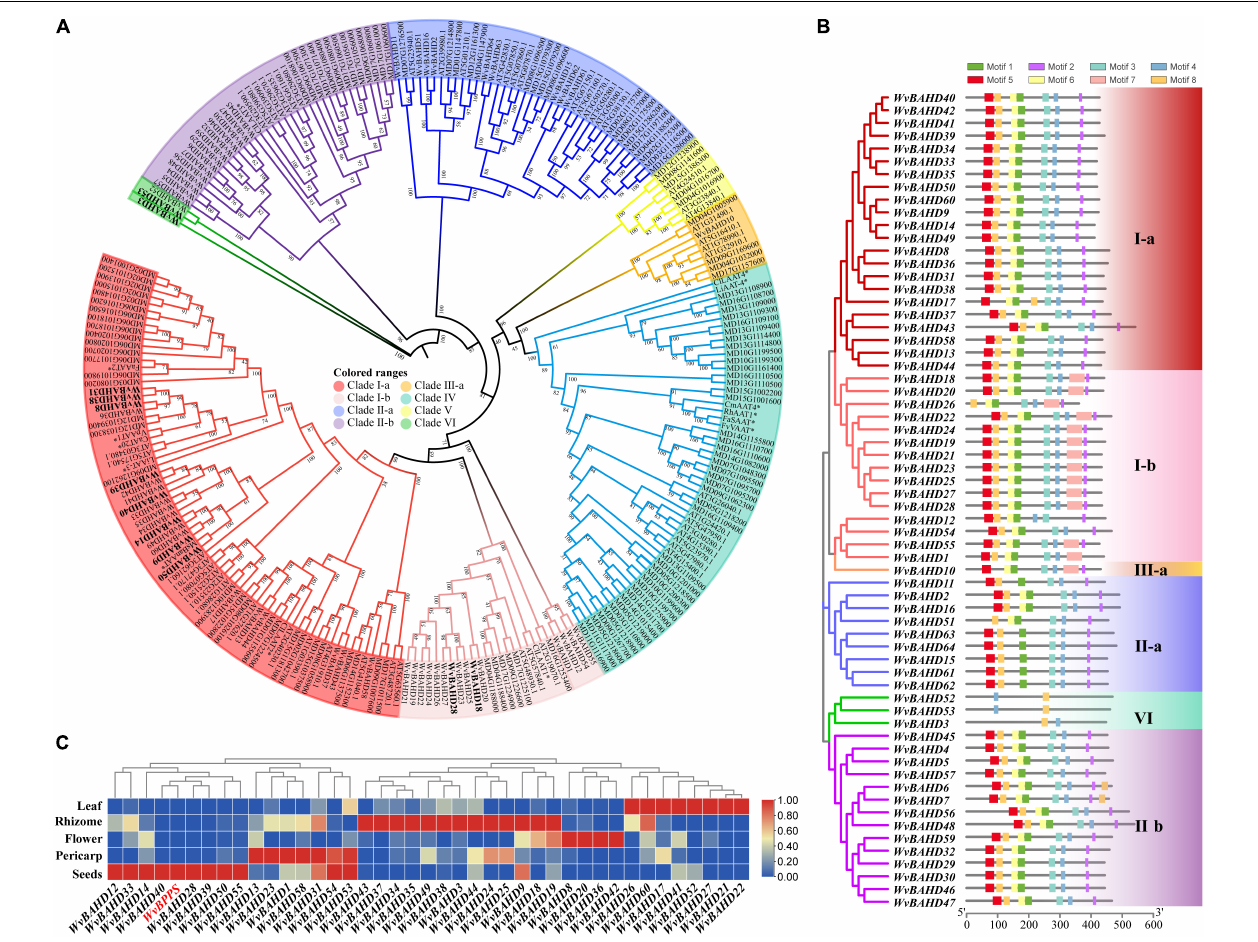
FIGURE 3 | (A) Phylogenetic analysis of WvBAHDs from Wurfbainia villosa , AtBAHDs from Arabidopsis thaliana, and MdBAHDs from Malus domestica , and 14 identified AATs marked with asterisk. The phylogenetic tree was constructed by maximum-likelihood with 1,000 replications, and the clade of clustering was adapted from Liu et al. (2020). The WvAAT candidates were indicated in bold black font. (B) Conserved motifs analysis of WvBAHDs. Legend depicting the amino acid sequence of the conserved motifs were shown in Supplementary Figure 1 . (C) Transcriptome differential expression analysis of WvBAHDs from clade om clare 1. (C) nd WvBPPS . Pericarp and seeds were from 60-DAF (Days after flowering) fruits.